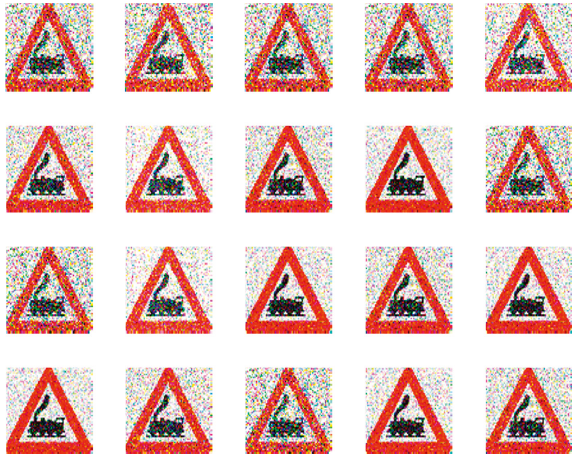
Figure 5: Effect of Gaussian noise on the one